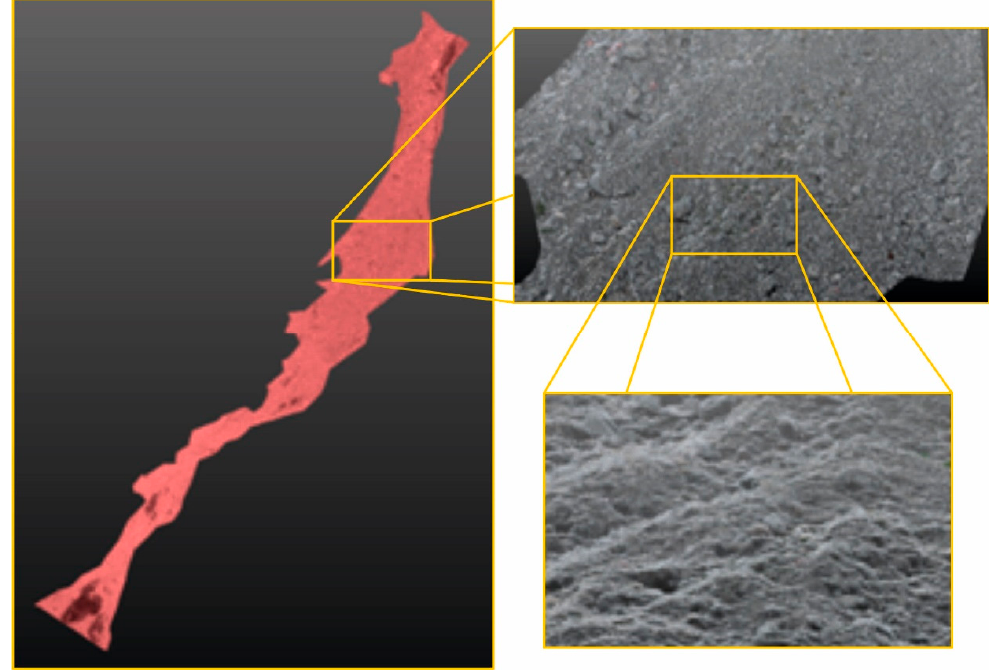
Figure 11. UAS structure-from-motion (SfM) photogrammetric point cloud (general view and details).